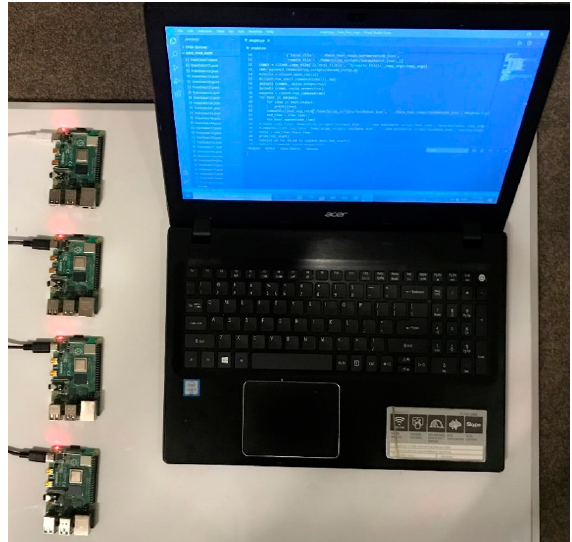
Figure 3. Emulated v-FAP for offloaded DL tasks.